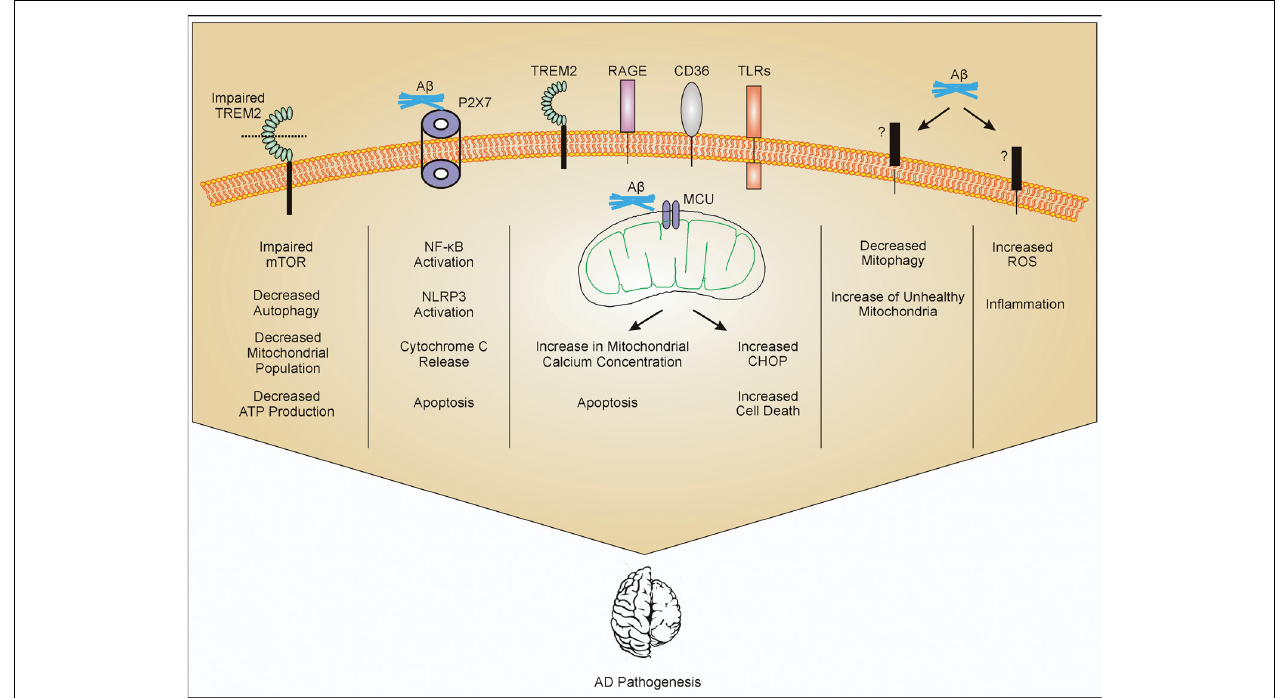
FIGURE 1 | Mitochondrial dysfunction in microglia. Amyloid- β (A β ) interacts with different receptors present on microglia. Impaired triggering receptor expressed in myeloid cells 2 (TREM2) leads to impaired mammalian target of rapamycin (mTOR) pathway. Impaired mTOR pathway increases autophagy and decreases population of mitochondria which further decrease the production of ATP. A β interaction with P2X 7 activates NF- κ B and leads to activation of NLRP3 and release of cytochrome c (cytc) from mitochondria (mechanism not clear) and apoptosis. A β gets phagocytosed through different receptors such as TREM2, toll-like receptors (TLRs), receptor for advanced glycosylation end products (RAGE), and CD36, and internalized A β interacts with mitochondrial calcium uniporter (MCU) on mitochondria leading to cell cytotoxicity. Through unknown receptors (?), A β decreases mitophagy and also increases reactive oxygen species (ROS) production. All these mechanisms contribute to Alzheimer’s Disease (AD) pathogenesis through inflammation or other mechanisms which are still under investigation.